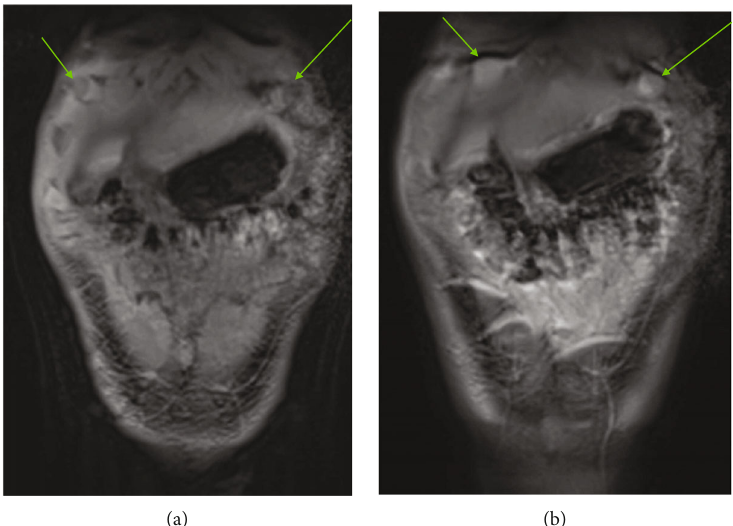
Figure 3: (a) T1 coronal images precontrast and (b) T1 postcontrast images demonstrating enhancing pleural nodules.